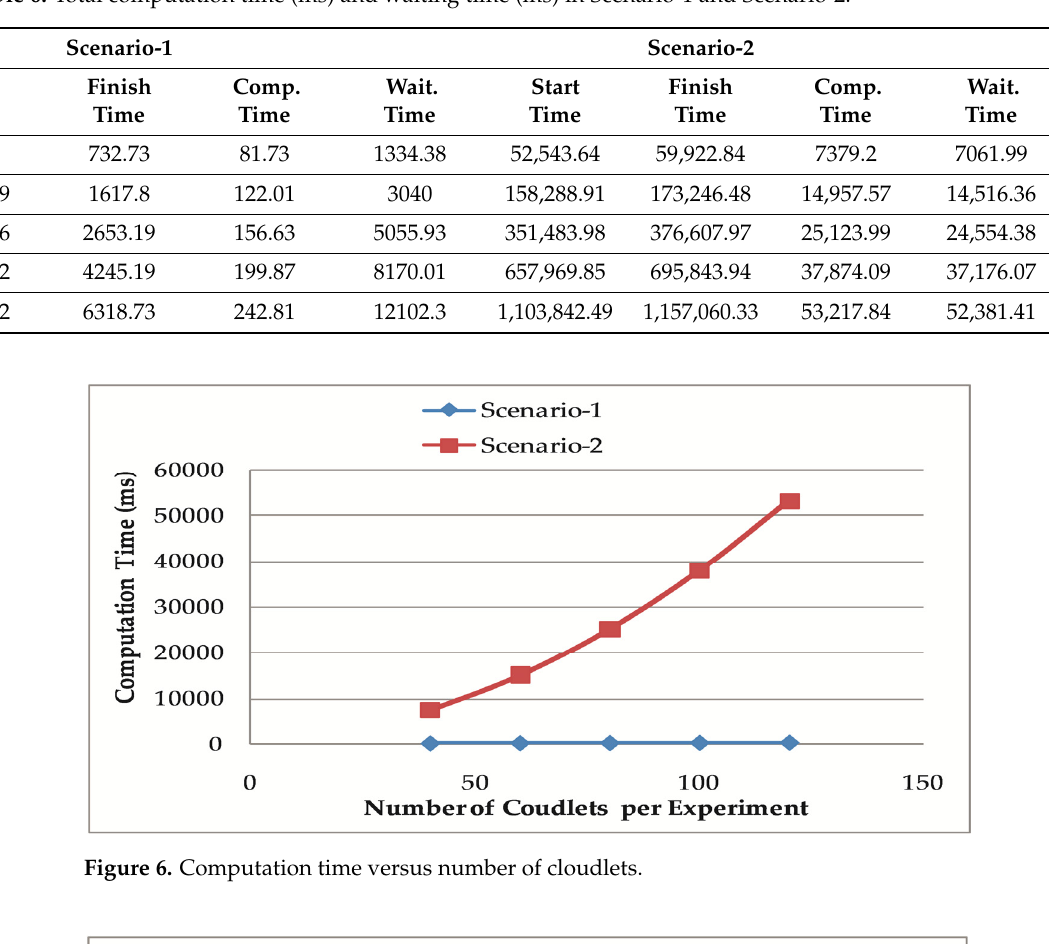
Figure 7. Waiting time versus number of cloudlets.